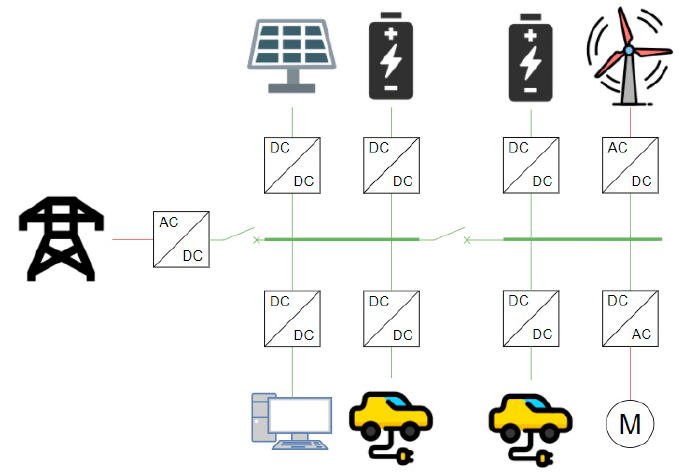
Figure 4. Radial series configuration.